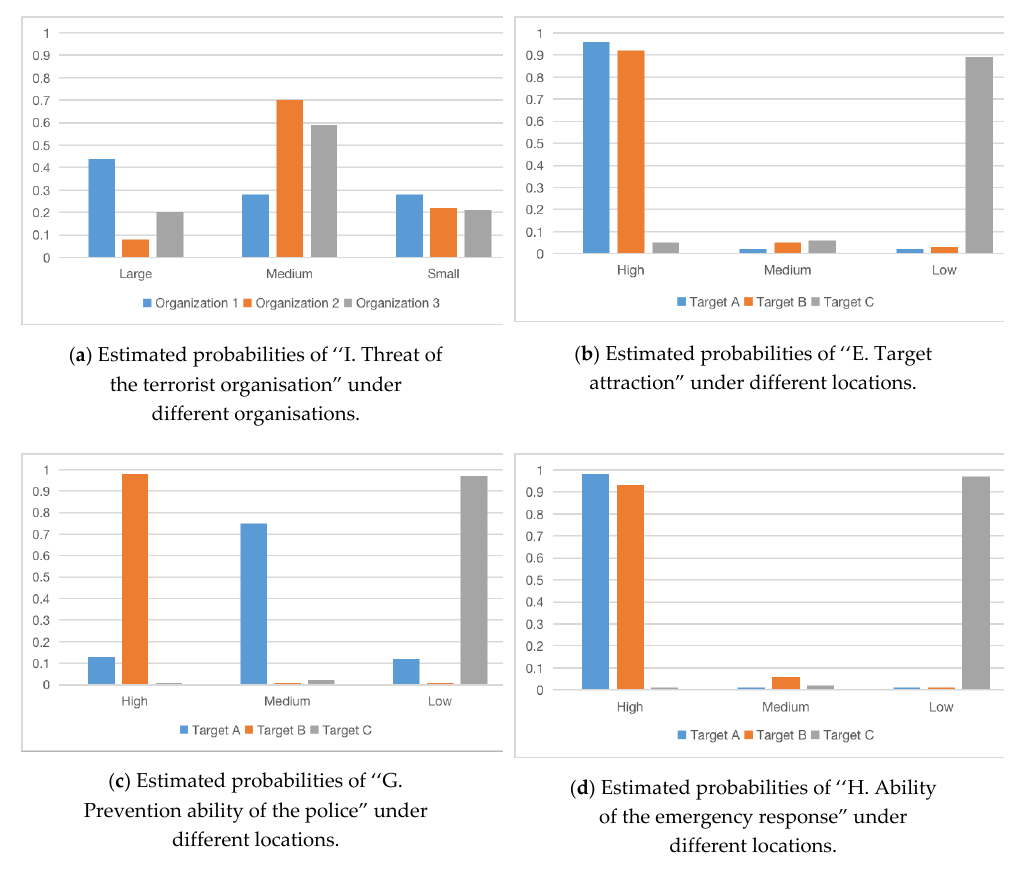
Figure 5. Estimated probabilities of nodes I, E, G, H under different organisations and targets.